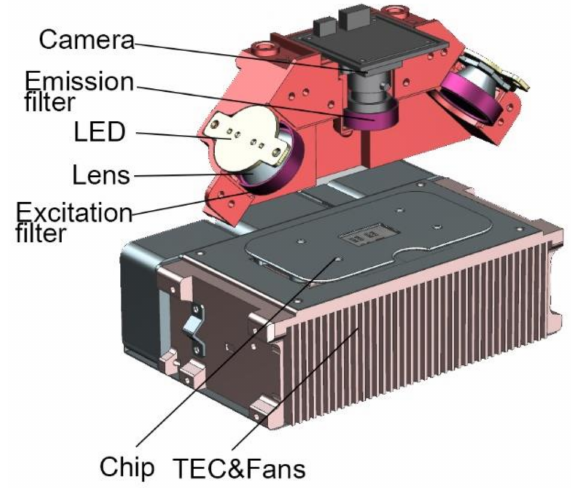
Figure 2. Optical detection system and thermocycling